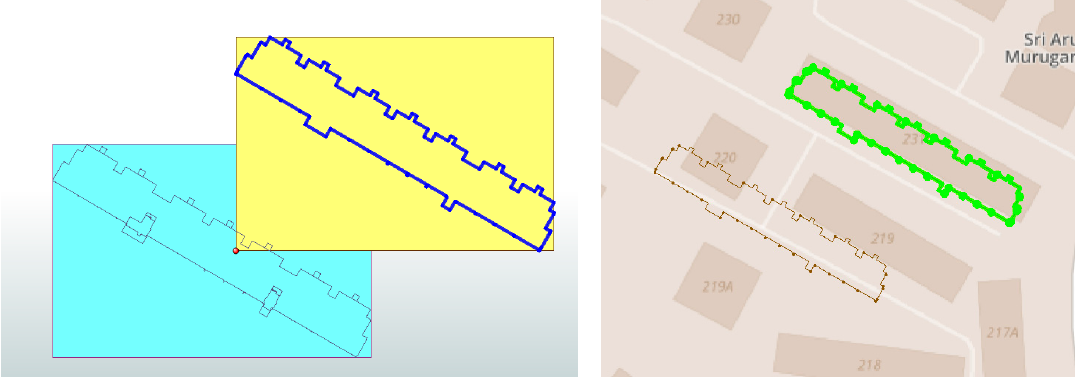
Figure 14. Bounding box of block 231 after translation.